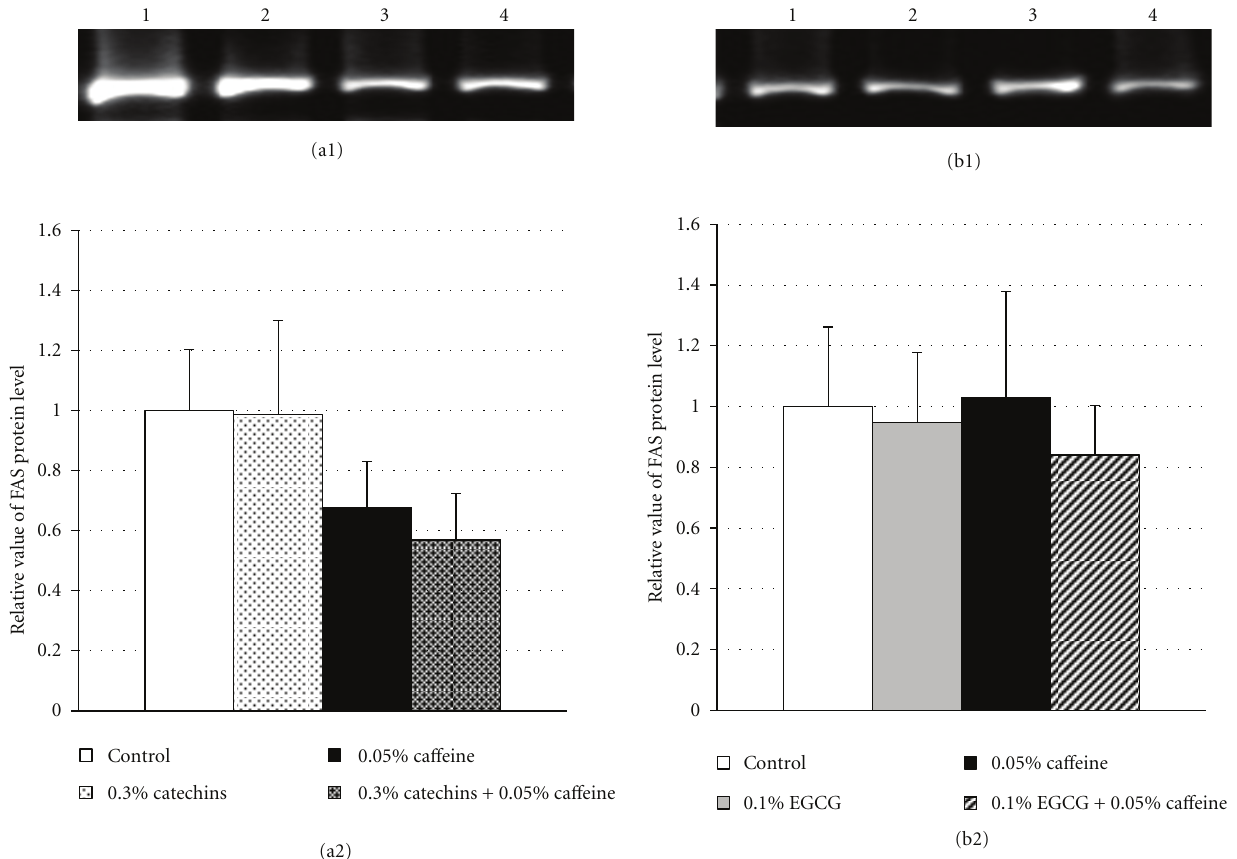
Figure 3: E ff ects of catechins, EGCG, and ca ff eine on protein levels of fatty acid synthase in liver in mice. (a1) Fluorescence intensity of fatty acid synthase (FAS) by Western Blotting analysis in liver in mice fed the diets containing 0.3% catechins, 0.05% ca ff eine, 0.3% catechins + 0.05% ca ff eine for 4 weeks. Lane 1: control, lane 2: 0.3% catechins, lane 3: 0.05% ca ff eine, lane 4: 0.3% catechins + 0.05% ca ff eine. (b1) Fluorescence intensity of FAS by Western Blotting analysis in liver in mice fed the diets containing 0.1% EGCG, 0.05% ca ff eine, 0.1% EGCG + 0.05% ca ff eine for 4 weeks. Lane 1: control, lane 2: 0.1% EGCG, lane 3: 0.05% ca ff eine, lane 4: 0.1% EGCG + 0.05% ca ff eine. (a2 and b2) The protein levels of FAS determined by Western Blotting analysis in liver in mice fed the diets containing catechins and ca ff eine (a2) and EGCG and ca ff eine (b2) for 4 weeks. The level was determined from the fluorescence intensity by a image analysis system and showed as a relative value to the control. Results are given as mean ± SE of 8 mice in each